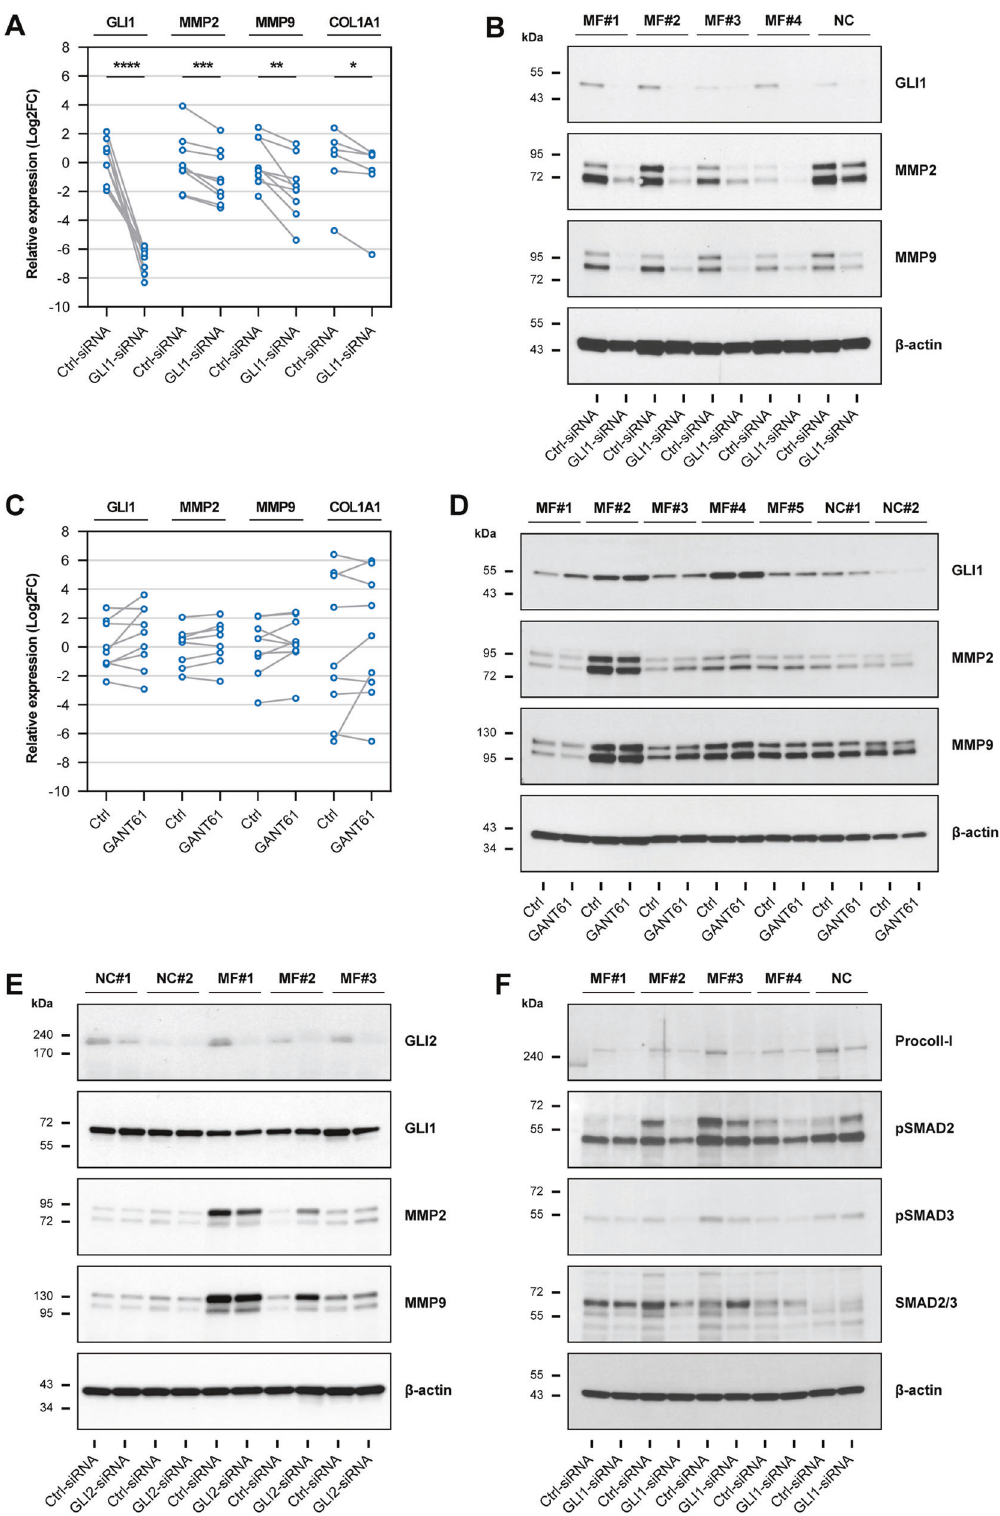
self-renewal or differentiation [42, 43]. In agreement with these reports we found that, unlike healthy donors ’ fi brocytes, MF patients ’ fi brocytes overexpress GLI1 that promotes the differentiation of fi brocyte progenitors into mature fi brocytes. Furthermore, we found that GLI1 exerts an anti-apoptotic effect on MF fi brocytes and,